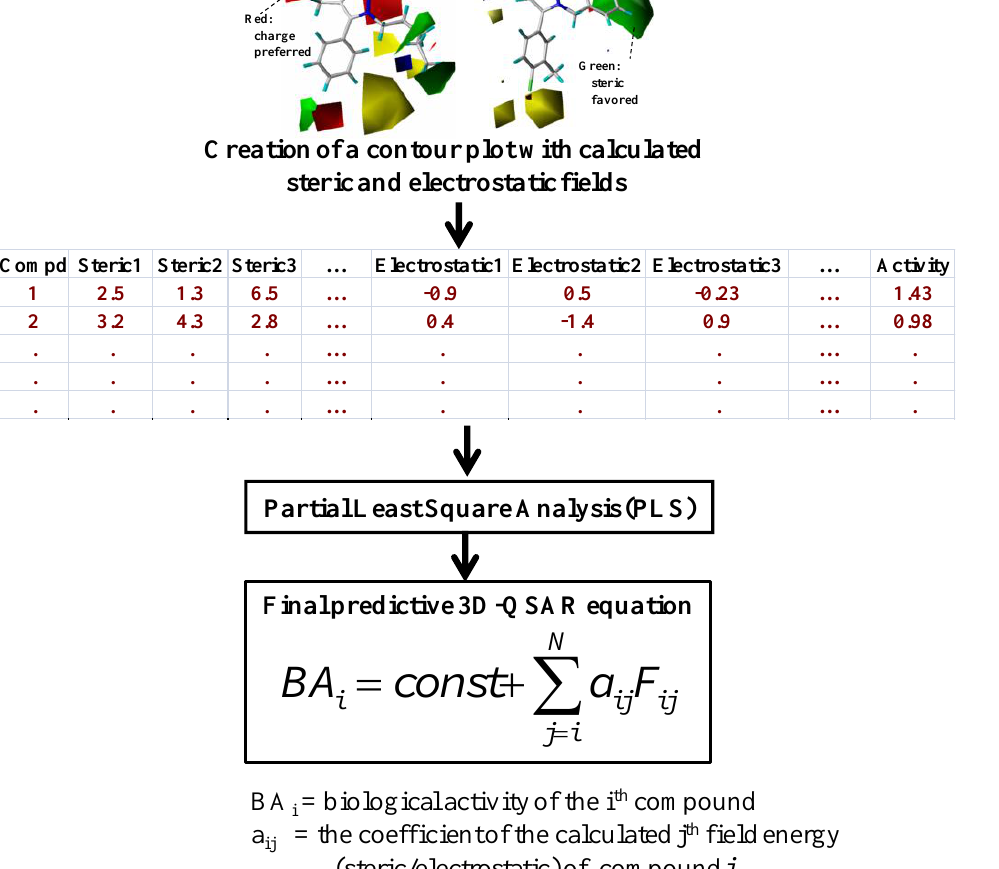
3D grid probing